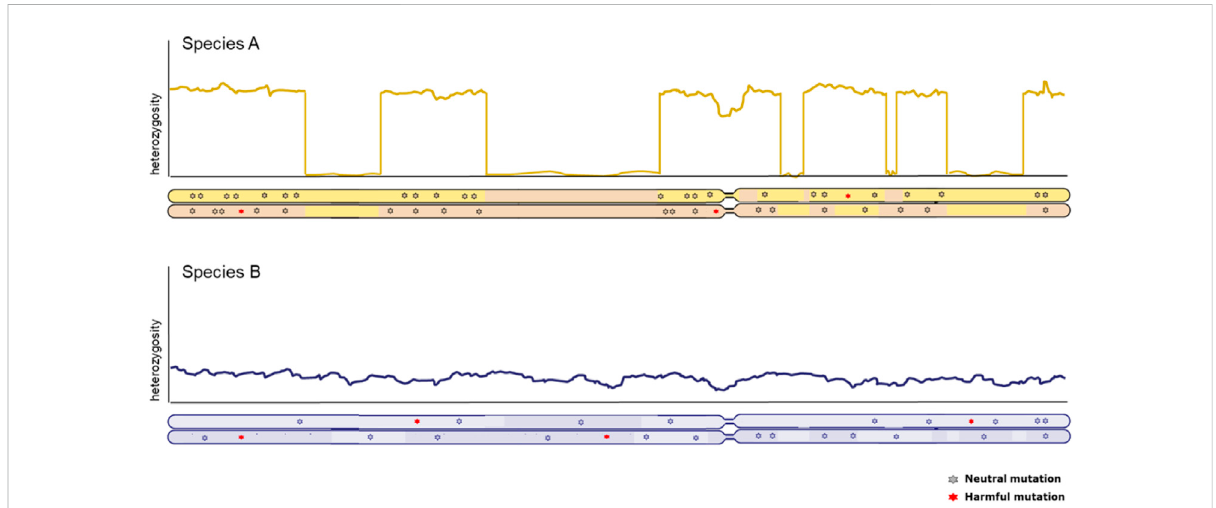
FIGURE 2 Chromosome-wide distribution of heterozygosity in individuals from two distinct populations with equal genome-wide levels of diversity. X -axisrepresentsthefull lengthof achromosome,with thetwocopiesillustrated below. Y -axisrepresents theheterozygositylevel derived fromthe number of SNPs between both copies of thegenome inan individual. The long stretches without heterozygosity due to identicalcopiesof the same segment in the top individual are know as Runs of Homozygosity